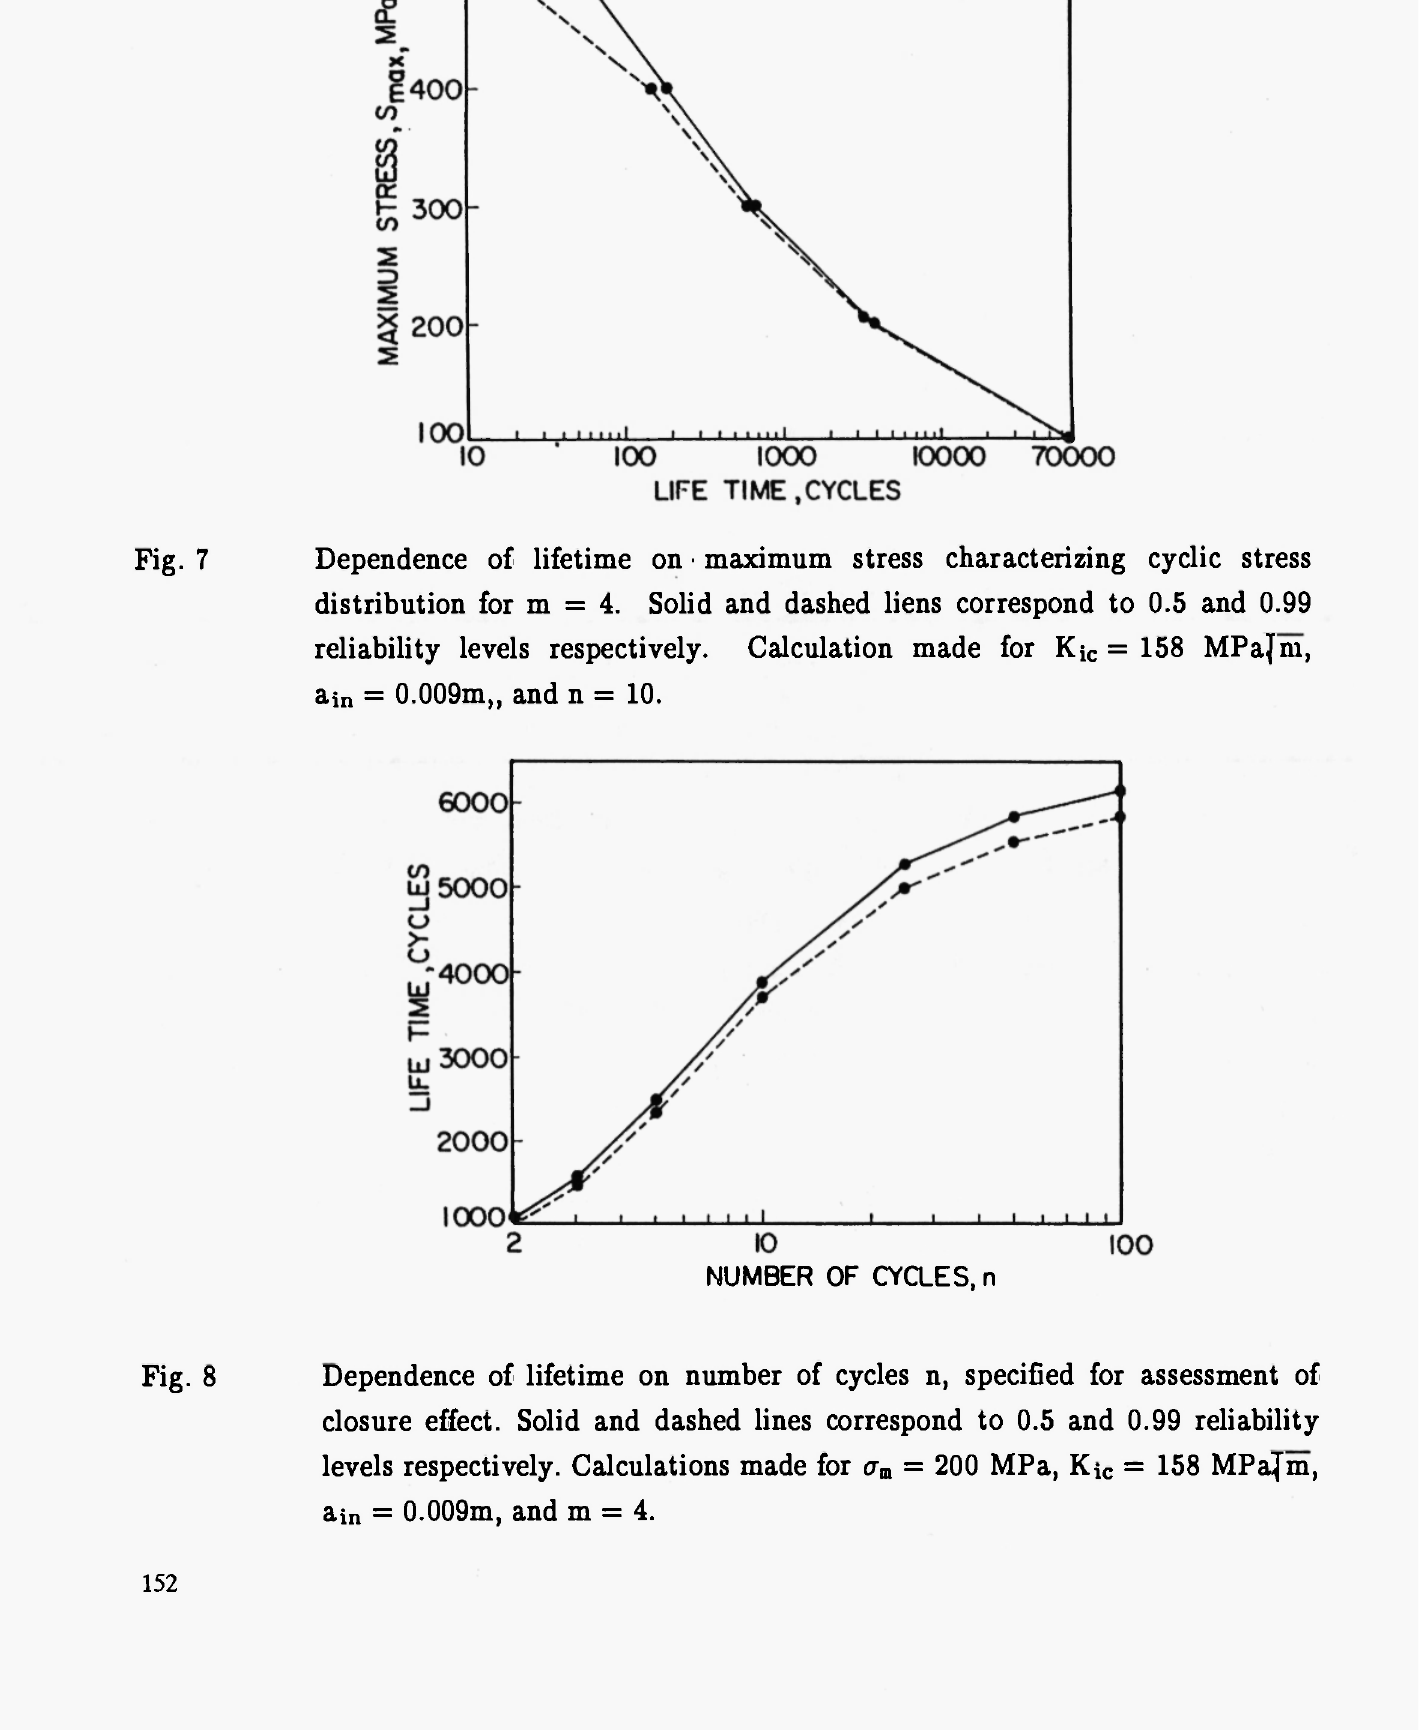
Fig. 8 Dependence of lifetime on number of cycles n, specified for assessment of closure effect. Solid and dashed lines correspond to 0.5 and 0.99 reliability levels respectively. Calculations made for a ain = 0.009m, and m =